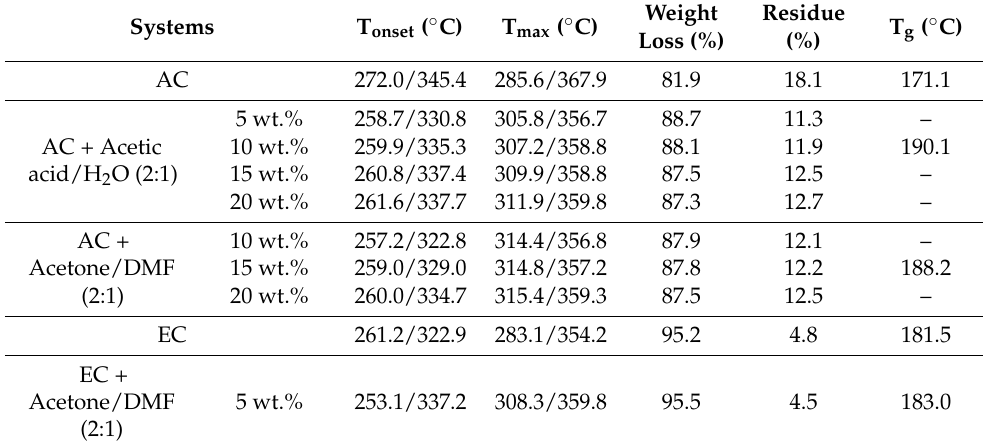
Table 2. Onset temperature (T onset ), maximum temperature (T max ), weight loss, residue percentage, and glass transition temperature (T g ) values obtained for the different raw materials and nanostruc- tured systems of AC and